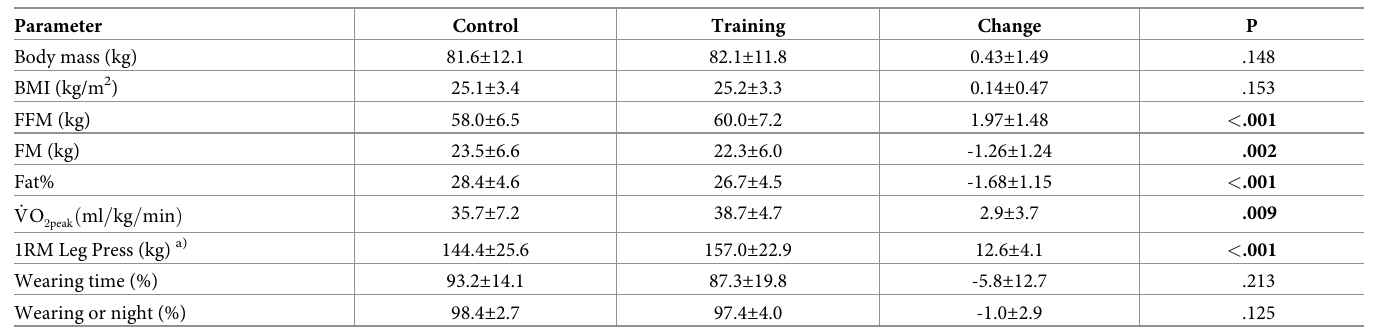
Table 2. Descriptive statistics of the subjects, and their adherence to wearing the motion